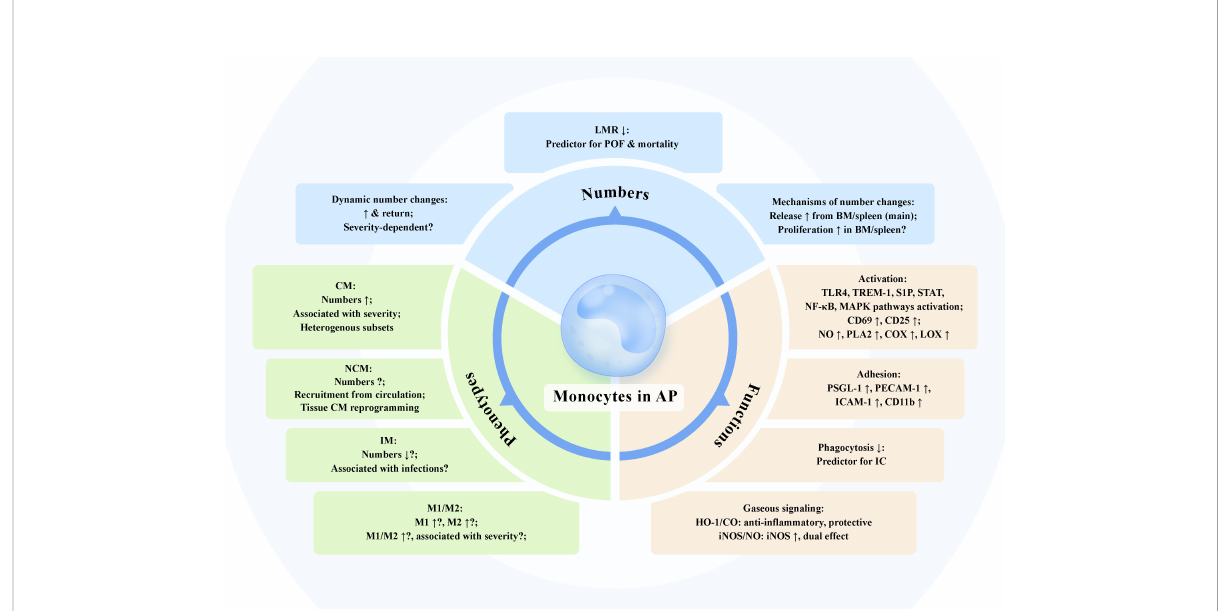
FIGURE 2 The dynamic changes of monocyte numbers, phenotypes, and functions in acute pancreatitis. Numbers: The number of monocytes in circulation and pancreas is dynamically elevated and might return at various timepoints of experimental and clinical acute pancreatitis (AP). The association of the increased number of monocytes with severity of AP has not been fully veri fi ed, despite that the increase in monocytes is more pronounced in more severe phenotype in some cases. Lymphocyte-to-monocyte ratio (LMR) is negatively correlated with AP severity and serves as a predictive index for persistent organ failure and mortality. The augmented number of monocytes within a short time is mainly the function of the release from storage pools. The increased proliferation of monocytes and associated progenitors in bone marrow (BM) and spleen may also contribute to the increased circulating monocytes in AP. Phenotypes: Circulating classical monocytes (CM) levels are associated with escalating AP severity. Novel heterogeneous subsets of monocytes in AP have been identi fi ed. The role of non-classical monocytes (NCM) and intermediate monocytes (IM) in AP is still not known. Decreased number of IM in AP might associate with increased susceptibility to infections. Increased M1 and M2 monocytes together with higher M1/M2 ratio can be observed in AP, which possibly correlate with disease severity. Functions: Monocyte activation along with disturbed intracellular multiple signaling pro fi les and elevated activation markers including CD69 and CD25, leads to massive production of nitric oxide (NO) together with induction of phospholipase A2 (PLA2), cyclooxygenase (COX), and lipoxygenase (LOX). Monocytes in AP exhibit increased adhesion molecules including P-selectin glycoprotein ligand 1 (PSGL-1), platelet endothelial cell adhesion molecule-1 (PECAM-1), and intercellular adhesion molecule 1 (ICAM-1), promoting monocyte adhesion to endothelium and migration to the in fl amed pancreas. Impaired phagocytosis of monocytes in AP might be a useful predictor for infectious complication. Heme oxygenase-1 (HO-1)/carbon monoxide (CO) and inducible NO synthase (iNOS)/NO are pivotal gaseous signaling pathways in monocytes of AP. HO-1/CO pathway in monocytes exerts anti-in fl ammatory effect to dampen AP severity. Increased expression of iNOS in monocytes is observed in AP and the generated NO has dual effect on the production of pro-in fl ammatory mediators depending on